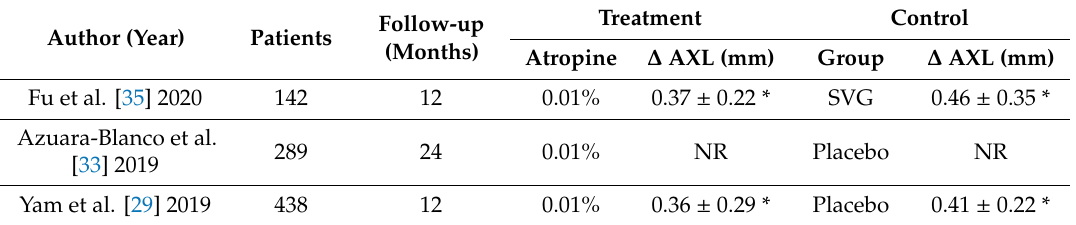
Table 1. Study characteristics and results summary of low-dose atropine